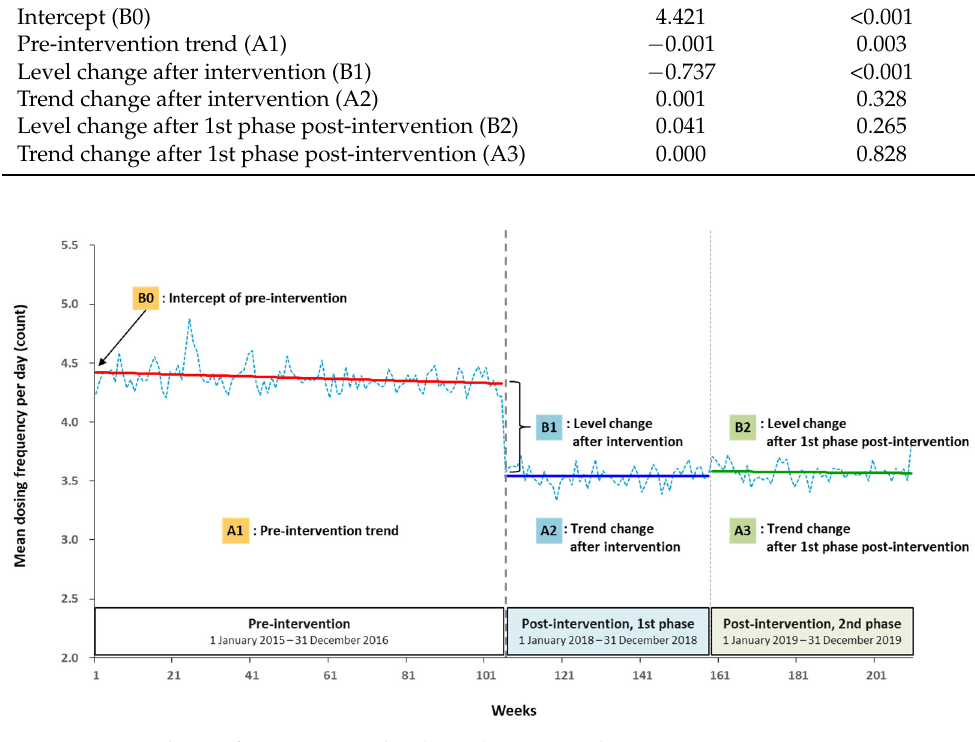
Figure 3. Mean dosing frequency per day (count) in pre- and